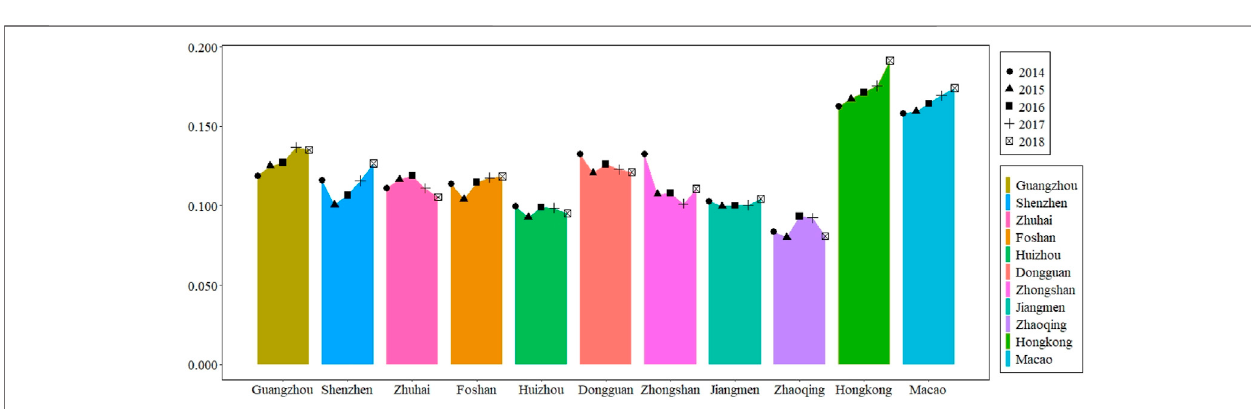
FIGURE 5 | Sustainable development level of the social subsystem in the GBA.